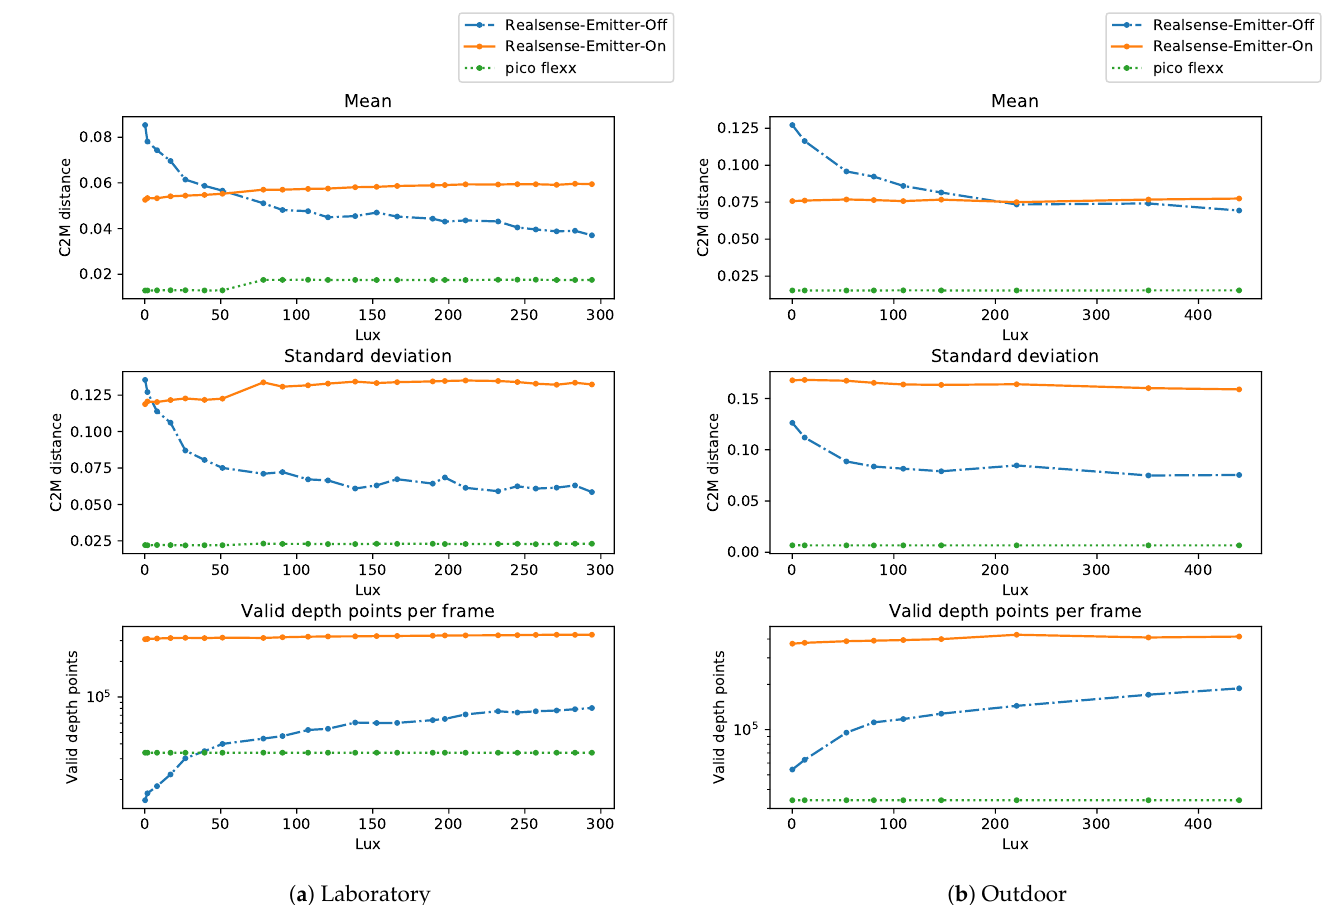
Figure 11. Mean (top), standard deviation (middle) of the reconstruction error, and (bottom), average number of valid depth points from each depth image of the camera. C2M distance: cloud to mesh